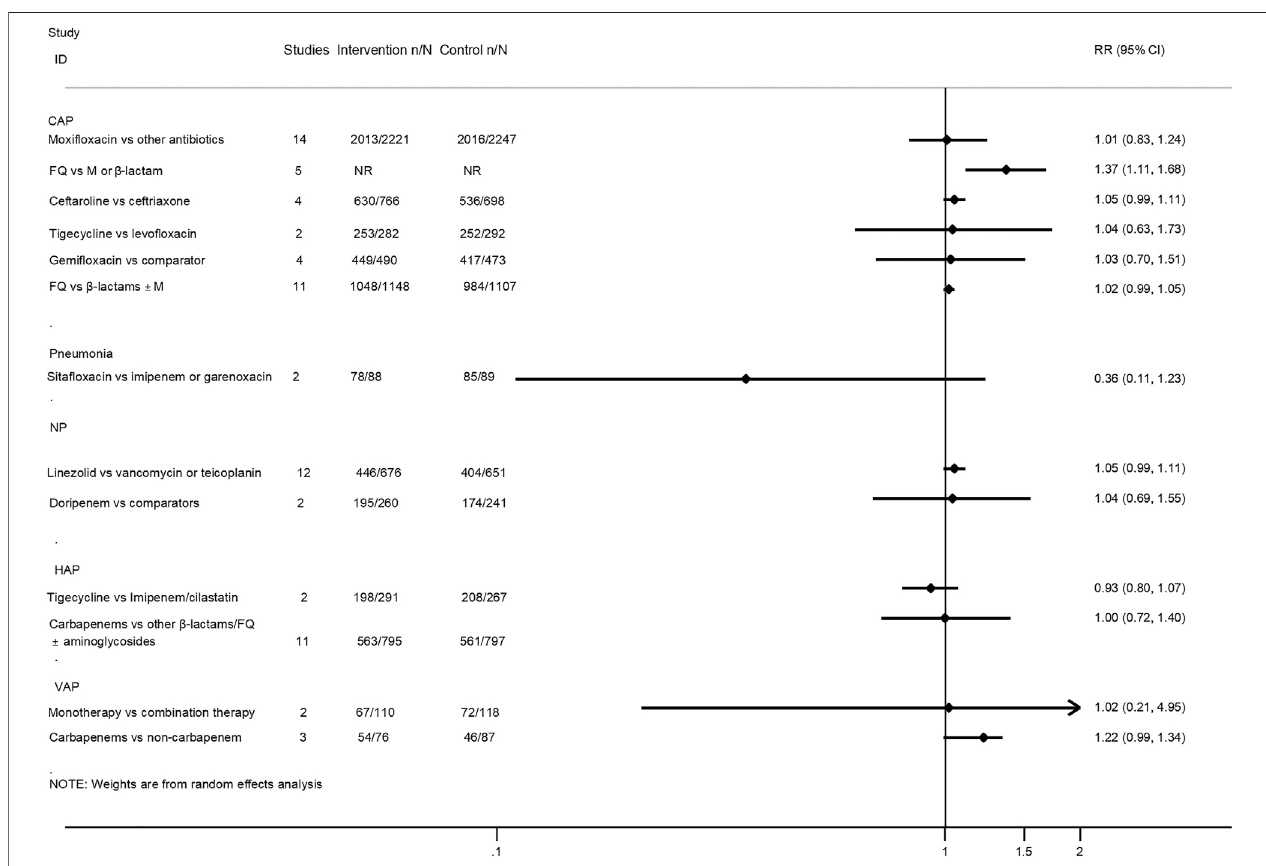
FIGURE 4 | Clinical treatment success analysis based on clinically evaluable